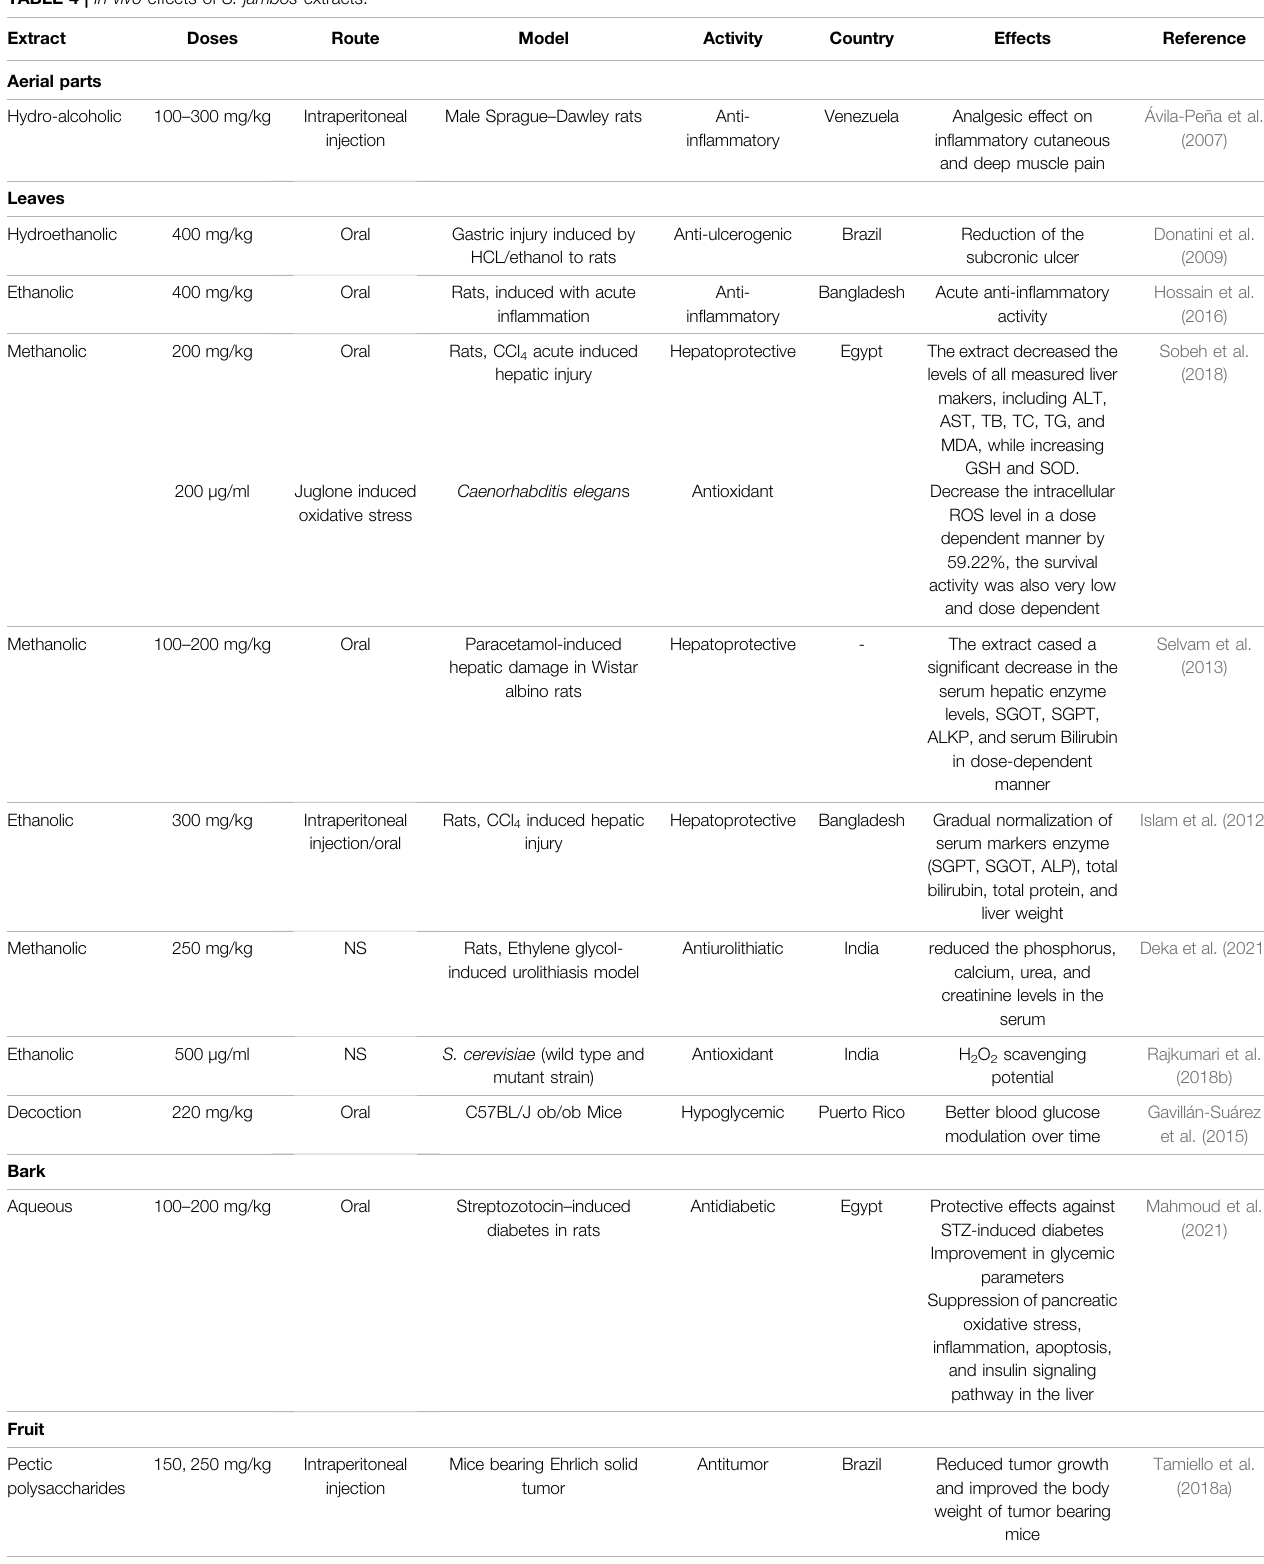
TABLE 4 | In vivo effects of S. jambos